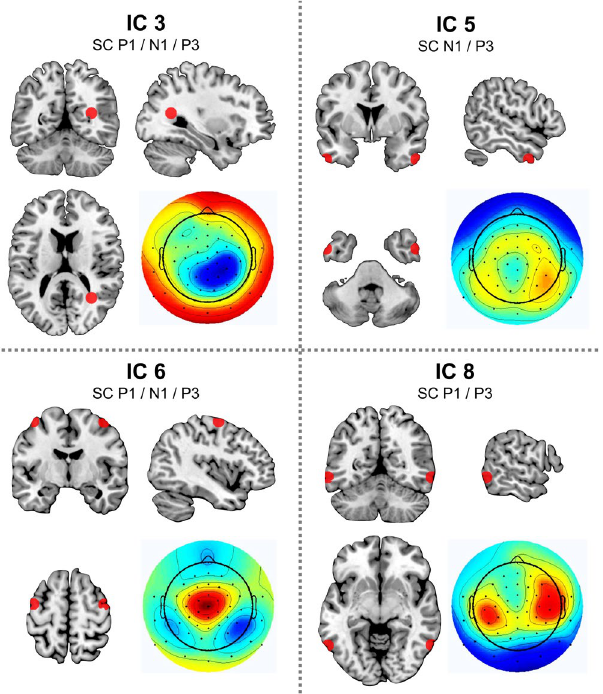
Figure 4. Relevant independent components. Illustration of the four independent components (ICs) which yielded significant task version differences within at least one of the time windows used for the quantification of ERP amplitude effects. IC 3 (top left) originated from BA 19 in the right middle temporal gyrus/occipital lobe (MNI coordinates: 31/ − 57/15) and yielded significant task version differences for all ERP time windows (i.e. P1, N1, and P3); the residual variance (RV) was 6.96%. IC 5 (top right) originated from bilateral BA 21 in the at the anterior part of the middle temporal gyrus (MNI coordinates: − 53/53/3/ − 39) and yielded significant task version differences for two ERP time windows (i.e. N1 and P3); RV = 30.95%. IC 6 (bottom left) originated from bilateral BA 6 the middle frontal gyrus (MNI coordinates: − 42/42/ − 6/62) and yielded significant task version differences for all ERP time windows (i.e. P1, N1, and P3); RV = 20.14%. IC 8 (bottom right) originated from BA 37 in the posterior parts of bilateral middle temporal gyrus (MNI coordinates: − 62/62/ − 58/ − 7) and yielded significant task version differences in two of the ERP time windows (i.e. P1 and P3); RV =